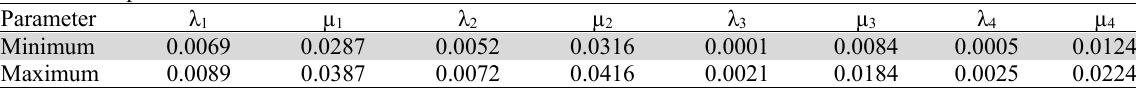
Failure and Repair Rate Parameter Constraints